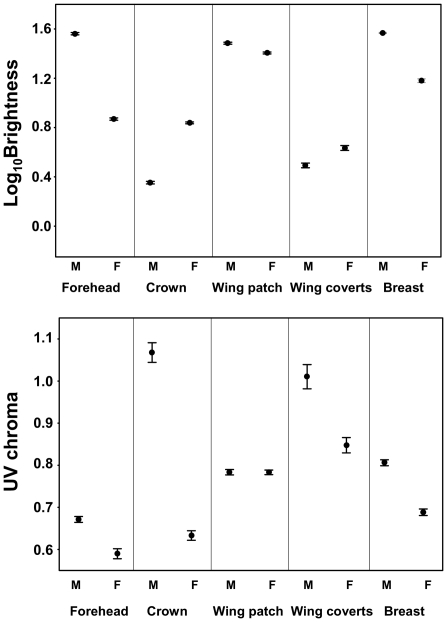
Sex comparisons of brightness and UV chroma for five plumage areas in collared flycatchers.Means±SE. Males (M), females (F). The analyses were performed on year-standardized data, but the figures are based on unstandardized data to better show the absolute extent of the differences.